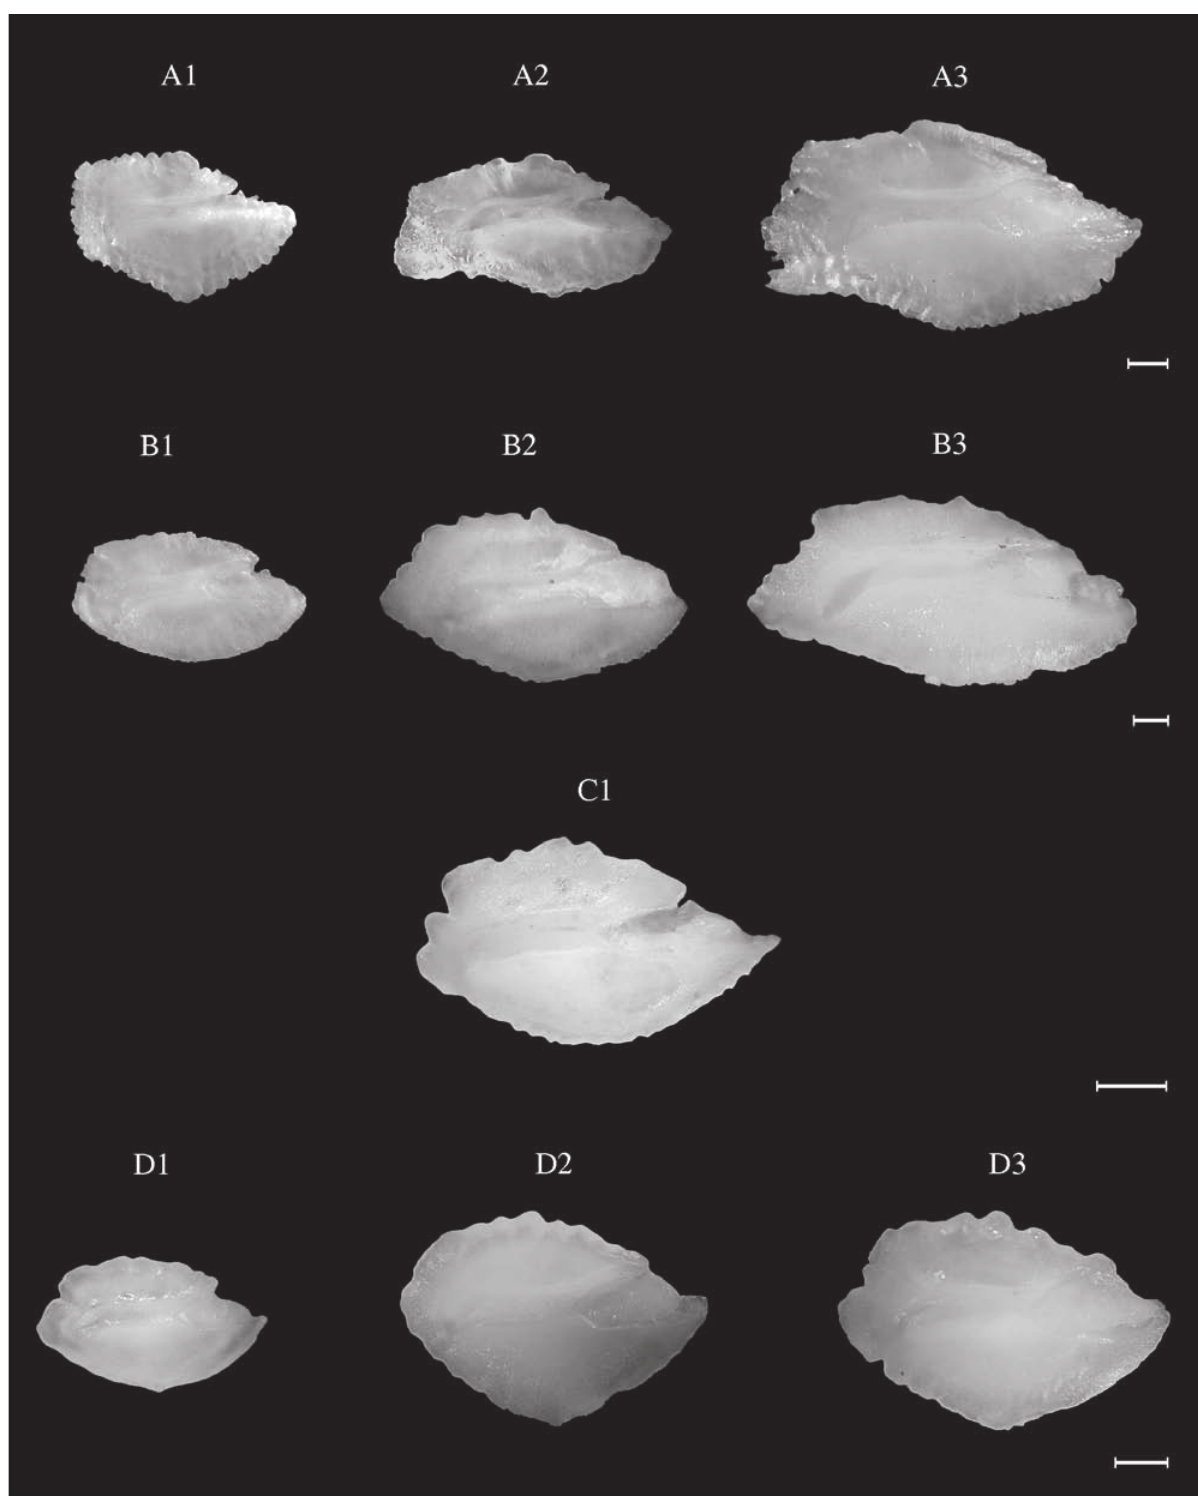
Fig. 62. – Sparus aurata. TL: A1, 17.8 cm (WM); A2, 22.5 cm (WM) ; A3, 32.4 cm (NEA). Spondyliosoma cantharus. TL: B1, 18.6 cm (NEA); B2, 27.0 cm (WM); B3, 33.8 cm (CEA). Centracanthus cirrus (WM) . TL: C1, 17.0 cm. Spicara flexuosa. TL: D1, 13.5 cm (WM); D2, 18.5 cm (NEA); D3, 20.5 cm (WM). Scale bar = 1